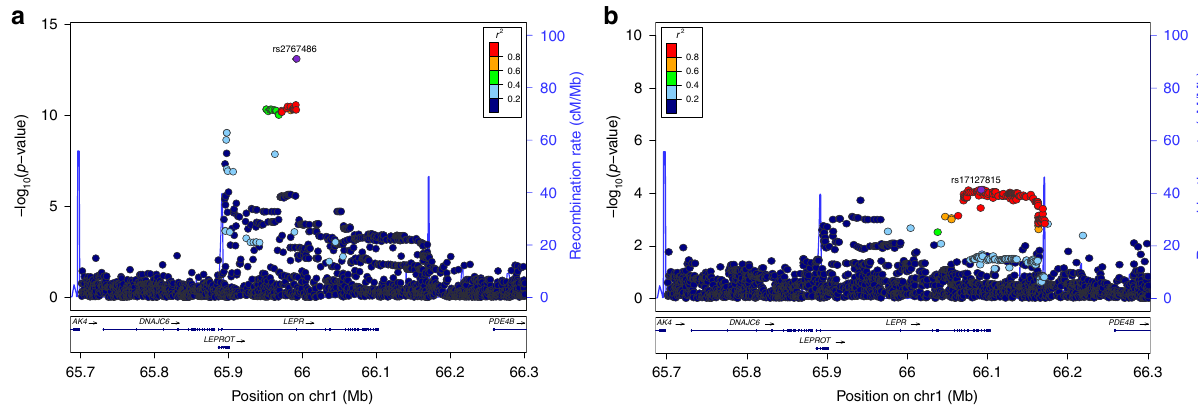
Fig. 5 Association in the LEPR locus. Regional association plot in the discovery sample in the LEPR locus at 6 months of age showing a the signal with lead SNP rs2767486 without conditioning, and b a putative second signal with lead SNP rs17127815 after conditioning on rs2767486